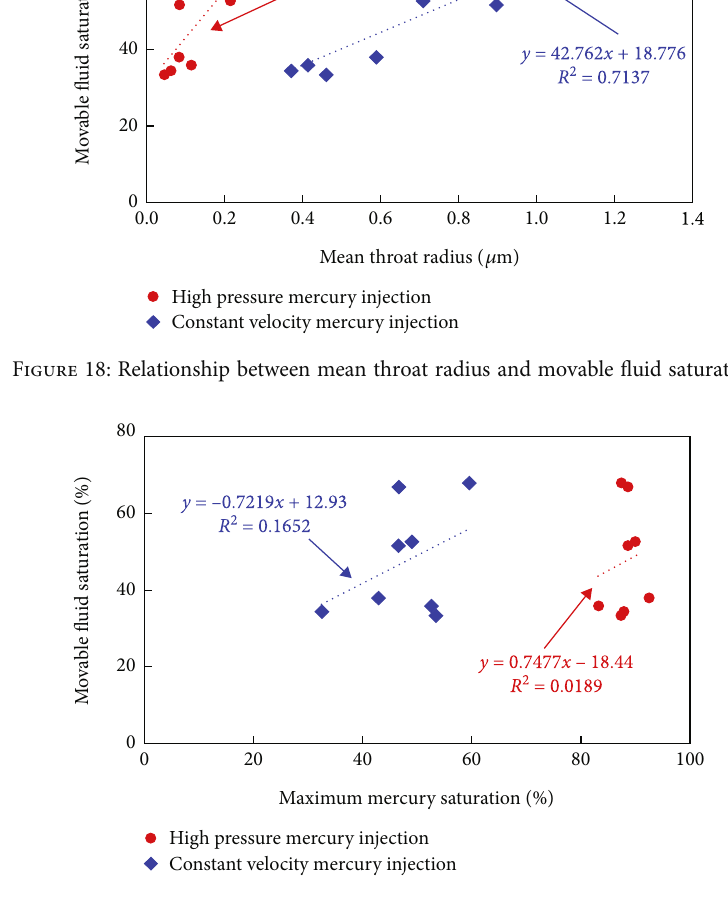
Figure 19: Relationship between maximum mercury saturation and movable fl uid